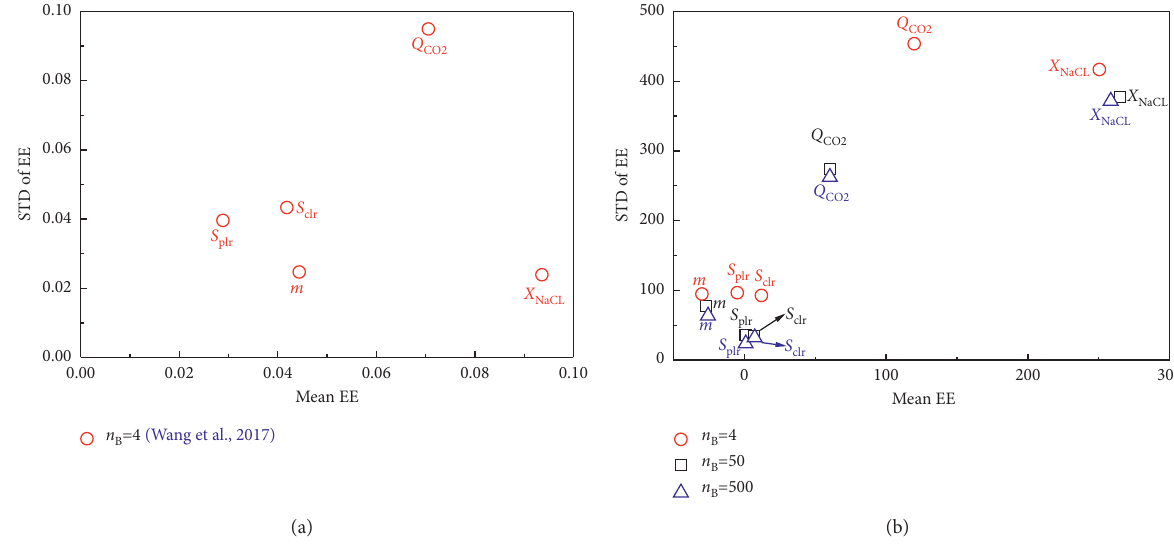
Figure 13: Morris global sensitivity analysis of S s near the injection well: (a) STD of EE versus mean EE at 100 days with 4 paths [32]; (b) STD of EE versus mean EE at 100 days, the circles, squares, and triangles represent 4 paths, 50 paths, and 500 paths,